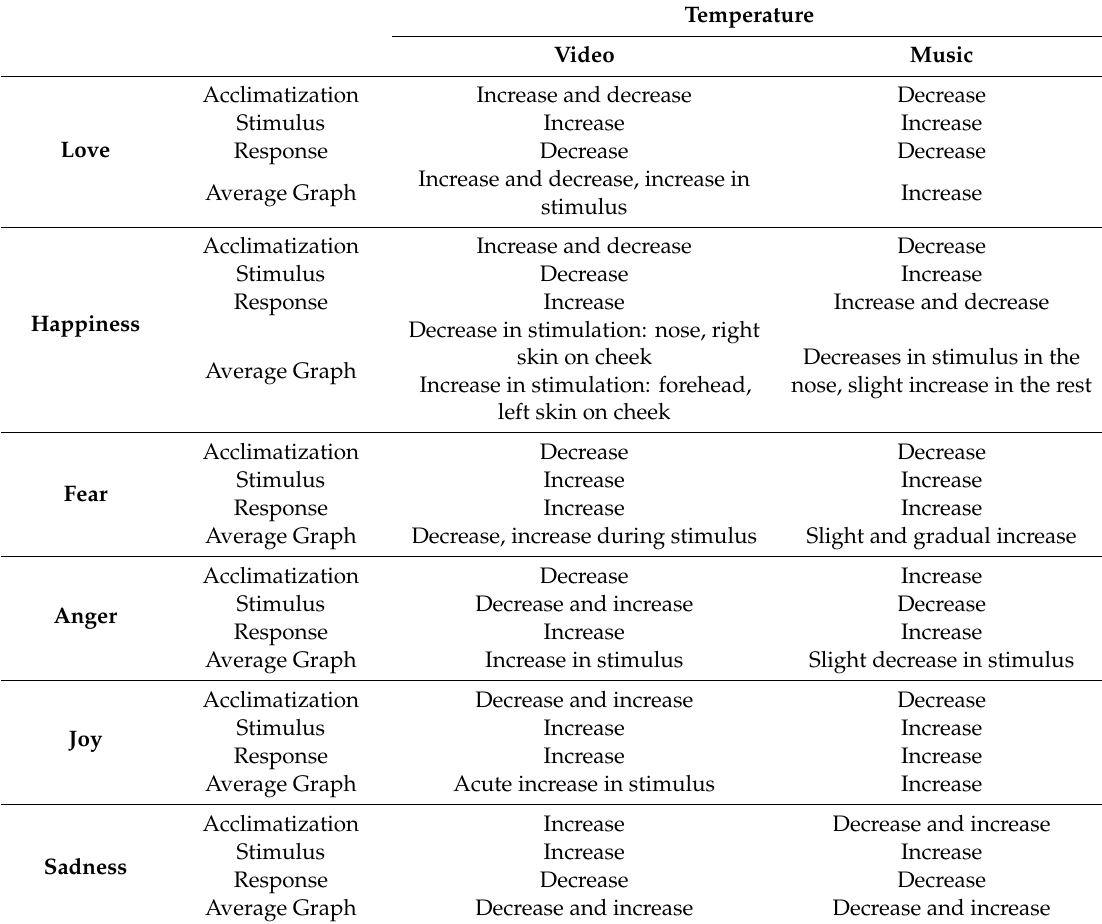
Table 6. Comparison of results of parts A and B of the